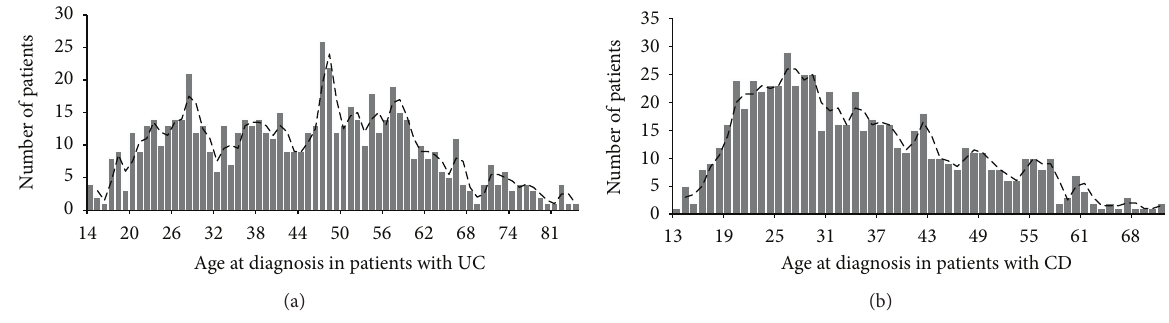
Figure 2: Age distribution of UC (a) and CD patients (b) for their first hospitalization.